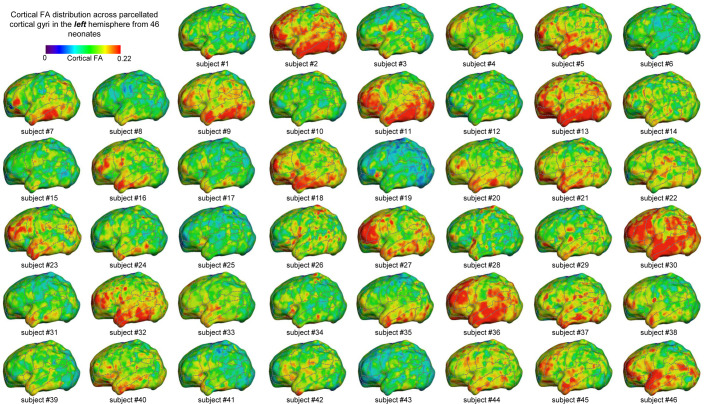
Cortical fractional anisotropy (FA) distribution across parcellated cortical gyri in the left hemisphere from 46 infants who also went through neurodevelopmental assessments with Bayley-III at their 2 years of age.Color bar on the upper left corner encodes the cortical FA values. The dashed lines demonstrate the boundaries among the parcellated cortical gyri.